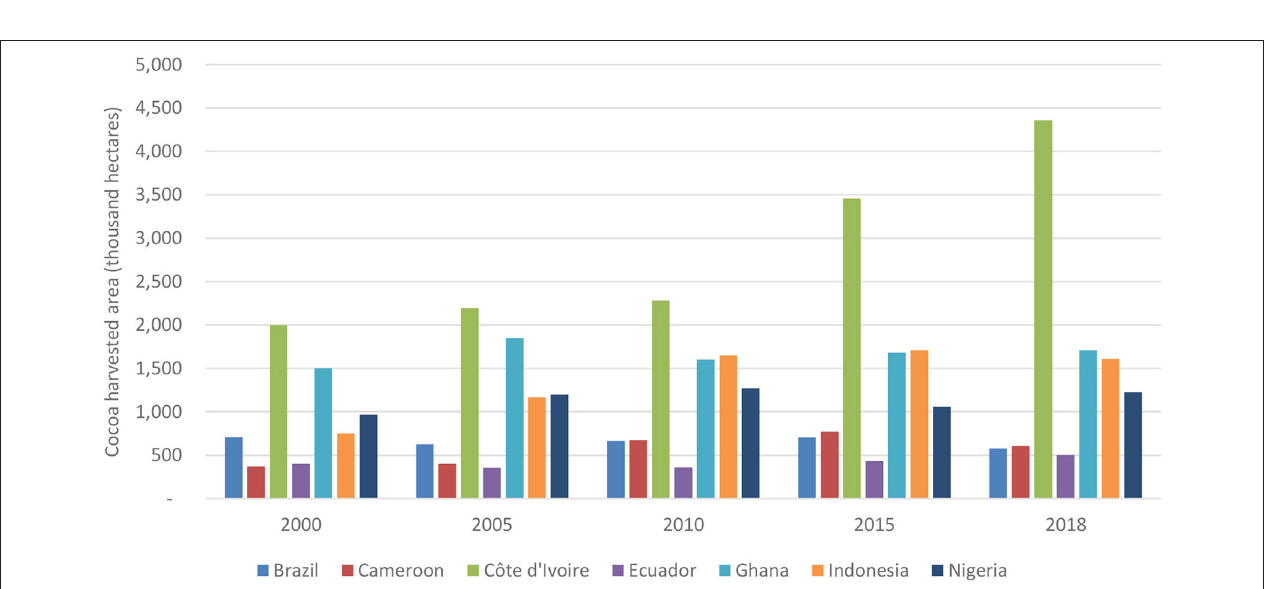
FIGURE 2 | Volume of cocoa exports by major exporting countries by type of cocoa, 2018. Source: (UN Comtrade, 2020) (data processed).